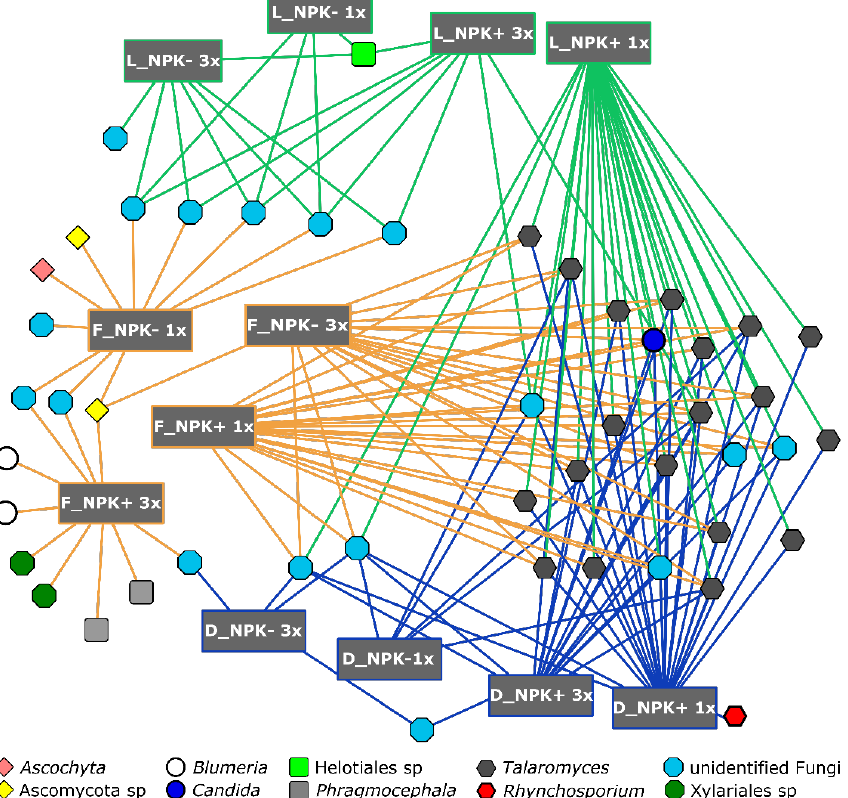
Figure 3. Bipartite association network of fungal zOTUs significantly associated with grass species and management level. Abbreviations: D, D. glomerata ; L, L. perenne ; F, F. rubra ; NPK-, no